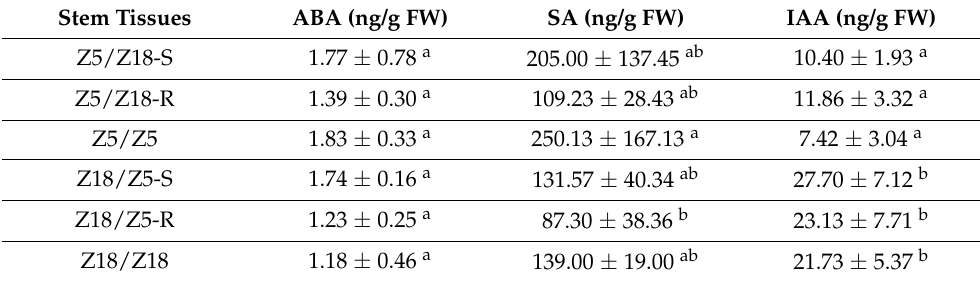
Table 2. Abscisic acid, salicylic acid, and indole-3-acetic acid contents by HPLC. Stem